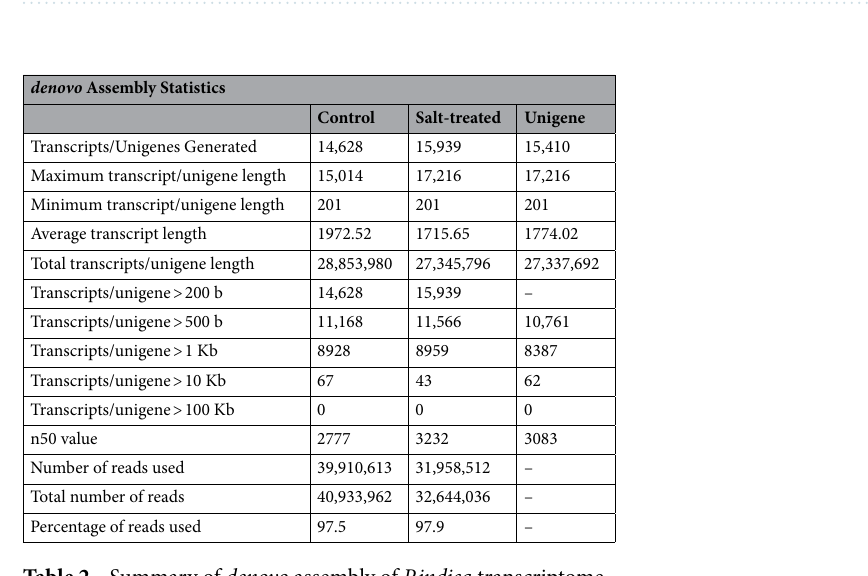
Table 2. Summary of denovo assembly of P.indica